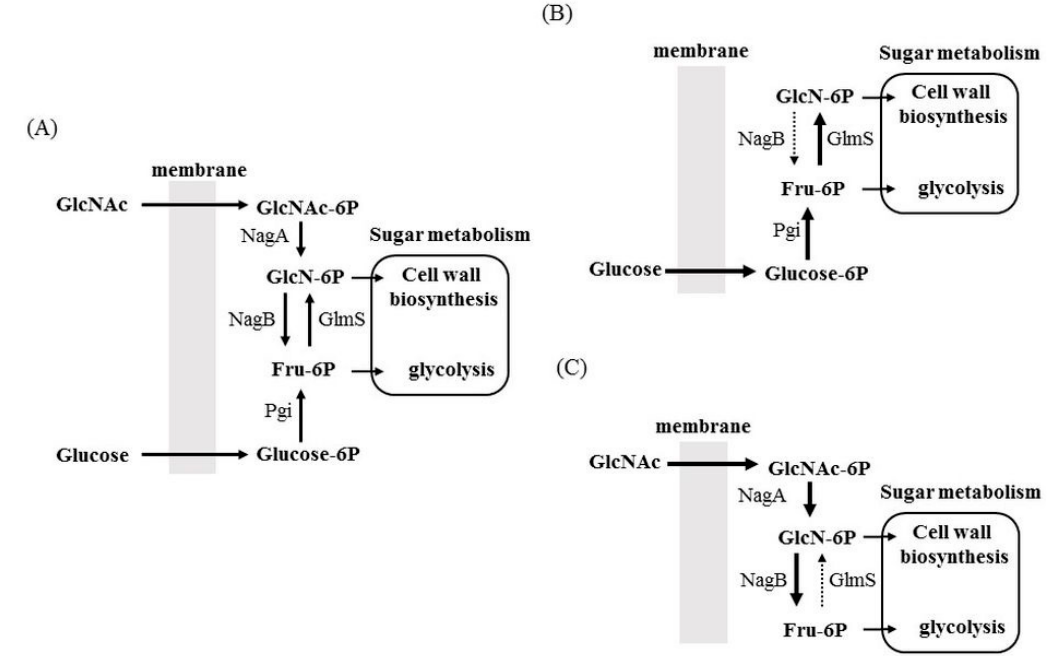
Figure 3. Proposed sugar distribution mediated by glutamine ‐ fructose ‐ 6 ‐ phosphate aminotransferase (GlmS) and glucosamine ‐ 6 ‐ phosphate deaminase (NagB). ( A ) In the presence of sugar (glucose) and amino sugar (GlcNAc), both sugars are incorporated into the cytoplasm and are distributed to cell wall synthesis and glycolysis by GlmS and NagB; ( B ) In the presence of glucose as a sole carbohydrate source, NagB expression is significantly suppressed to generate enough GlcN ‐ 6P for the cell wall biosynthesis pathway; ( C ) In the presence of GlcNAc as a sole carbohydrate source, GlmS expression is significantly suppressed to generate enough Fru ‐ 6P for glycolysis pathway. GlcNAc: N ‐